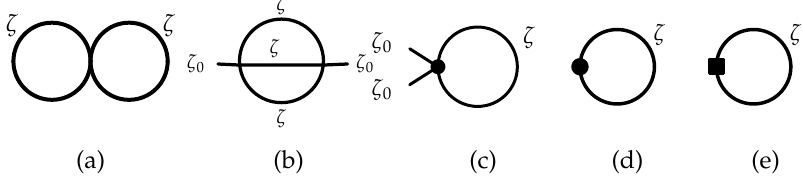
Figure 1. finite-temperature two-loop